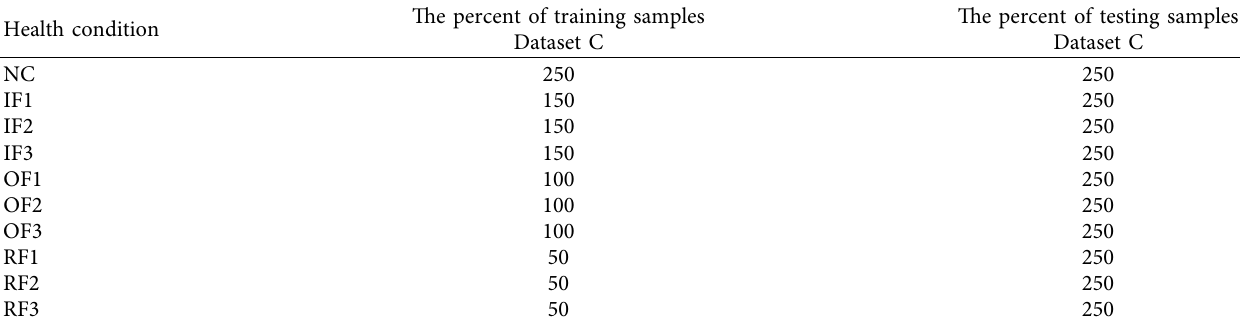
Table 2: Description of the unbalanced Dataset